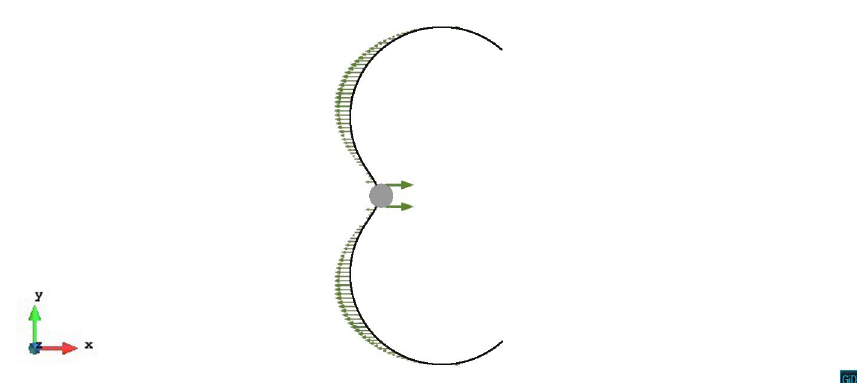
Figure 10. The dislocation topology and nodal force vectors in z / R = − 0.2 case. The plastic strain ε = 9.41 × 10 − 5 .